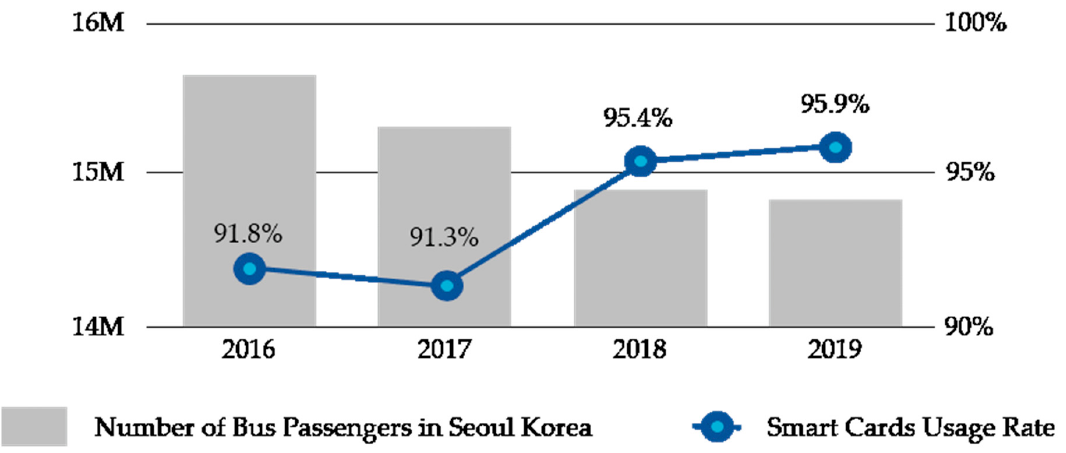
Figure 1. Number of bus passengers and use ratio of smart cards in Seoul Metropolitan City.